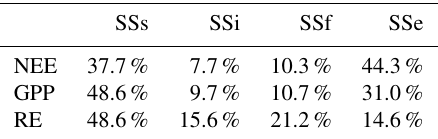
Table 5. The percentage of the contributions of the seasonal climatic variation (SS s ) , interannual climatic variability (SS i ) , the ecosystem functional change (SS f ) and random error (SS e ) to the interannual variations in NEE, GPP and